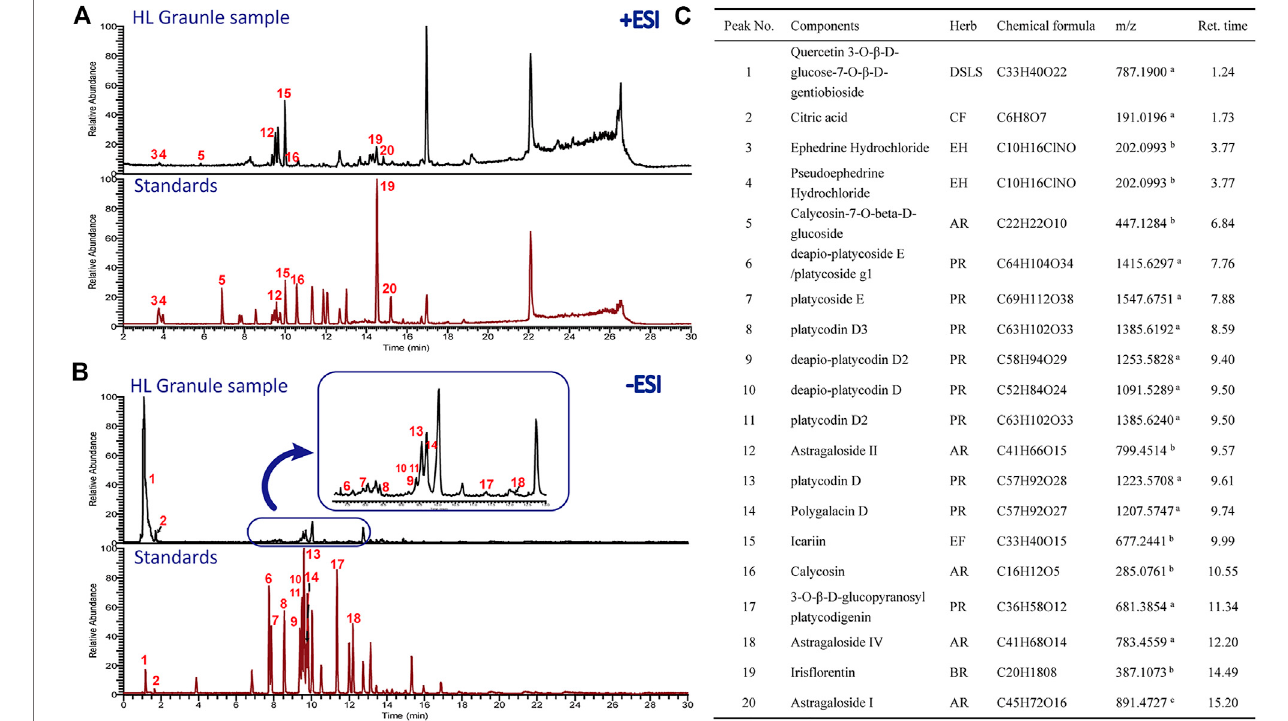
FIGURE2| ChromatogramofHPLCanalysisofHLGranuleextract. (A,B) TICsdetectedinpositive (A) andnegativeionmode (B) . (C) Majorchemicalandeffective components identi fi ed from HL Granule extract. In A and B, the upper of each picture is the chromatograms of the HL Granule sample, while the lower is the mixed standard reference compounds. Numbers in red corresponds to the chemical components in (C) . AR: Astragali Radix ( Astragalus atropilosulus ); BR: Belamcandae Rhizoma ( Belamcanda chinensis ); CF: Crataegi Fructus ( Crataegus pinnati fi da .); DSLS: Descurainiae Semen Lepidii Semen ( Lepidium apetalum ); EF: Epimedii Folium ( Epimedium brevicornu ); EH: Ephedrae Herba ( Ephedra sinica ); PR: Platycodonis Radix ( Platycodon grandi fl orum ). a [M − H] − ; b [M + H]+; c [M +